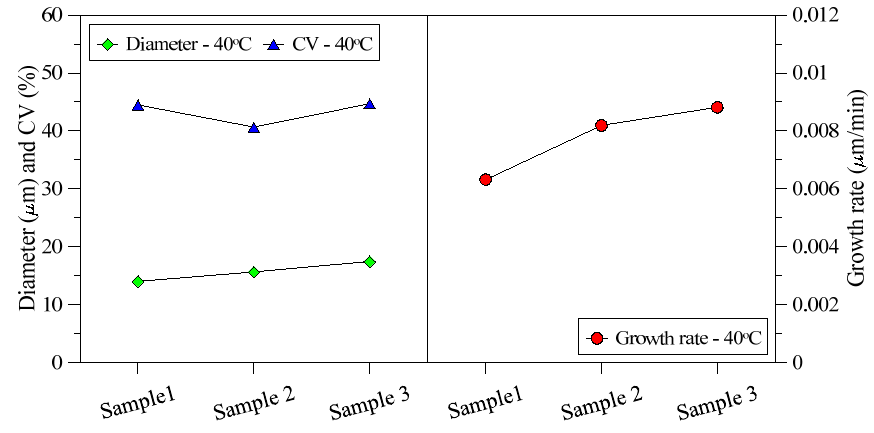
Figure 11. Diameter, coefficient of variance and growth rate for crystals recovered from semi-pilot plant at different time intervals.